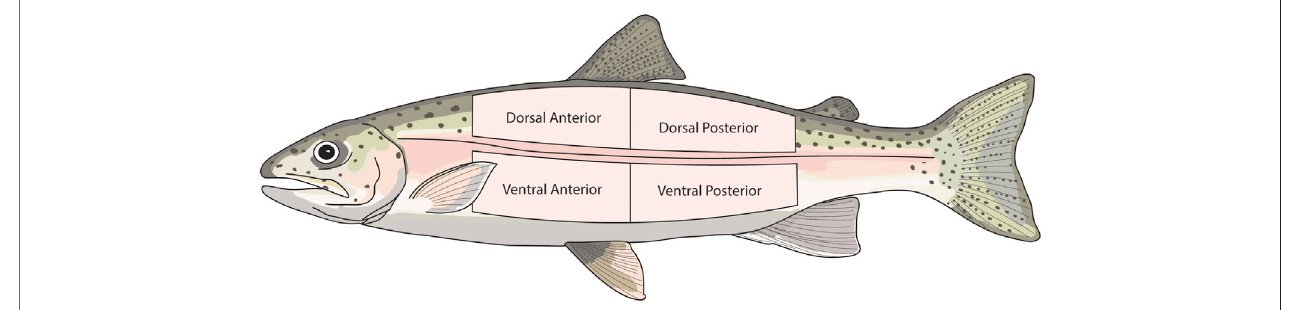
FIGURE1| Diagramshowingtheskinregionsthatweresampledinexperiment2.Thesameskinregionsweresampledfromboththerightandleftsideofeach fi